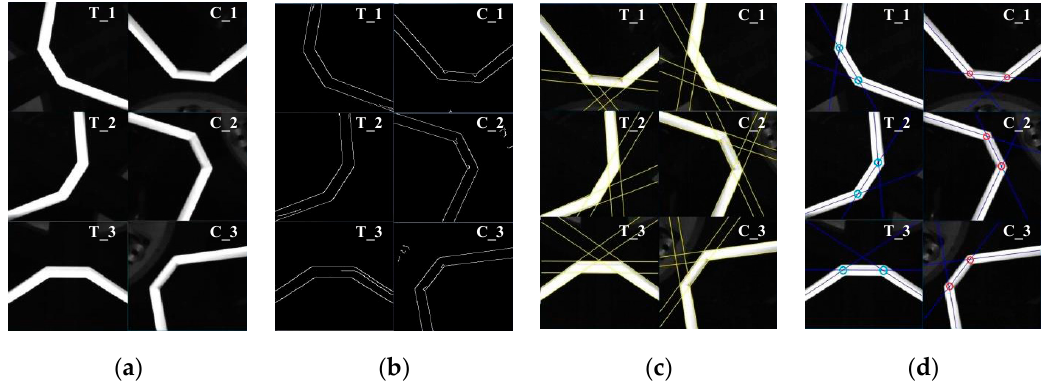
Figure 8. Image processing for multitarget tracking. ( a ) Image filtering. ( b ) Edge detection. ( c ) Line extraction. ( d ) Feature acquisition.